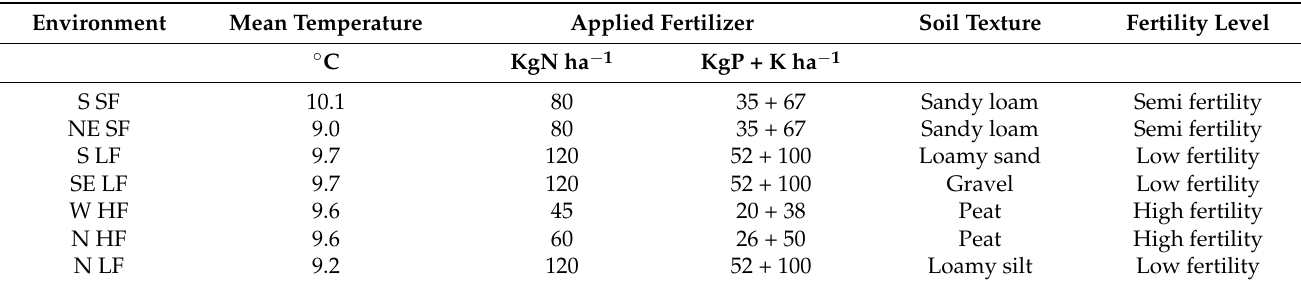
Table 1. Environment codes, daily mean temperatures, amount of fertilizer applied, soil texture and fertility levels. S: south; N: north; W: west; SE: southeast; NE: northeast; SF: semi-fertility; LF: low fertility; HF: high fertility. Environment Mean Temperature Applied